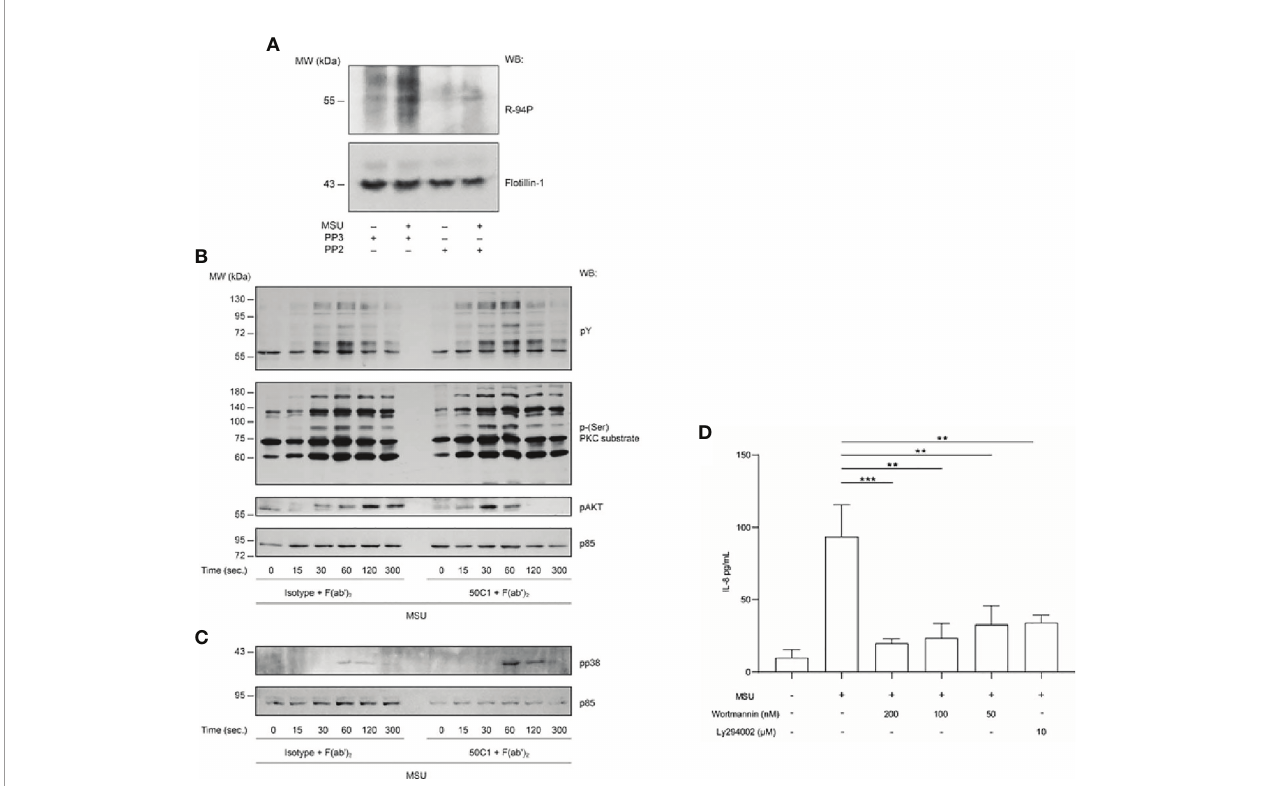
FIGURE 6 | Antibody-induced cross-linking of CLEC12A enhances the phosphorylation of tyrosine residues, PKC substrates, Akt and p38 to regulate MSU-induced IL-8 production in human neutrophils. (A) Plasma membranes were isolated from neutrophils incubated with PP2 or its inactive analog PP3 prior to MSU stimulation and immunoblotting with R-94P or an anti- fl otillin-1 antibody ( loading control ). Data are representative of 3 independent experiments. (B, C) CLEC12A was cross-linked on neutrophils with 50C1 prior to MSU stimulation and cell lysates immunoblotted with the indicated antibodies and the loading control antibody (anti-PI3K p85 subunit). pY = anti-phosphotyrosine antibody. Data are representative of 3 independent experiments. (D) CXCL8/IL-8 released by MSU-stimulated neutrophils in the presence or absence of Wortmannin, Ly294002 or dilutant (DMSO) was determined by ELISA. Data are representative of 3 independent experiments. Statistical analysis: Two-way ANOVA and the Turkey ’ s multiple comparisons test was performed to compare the treated cells to the control cells. **P < 0.01; ***P <